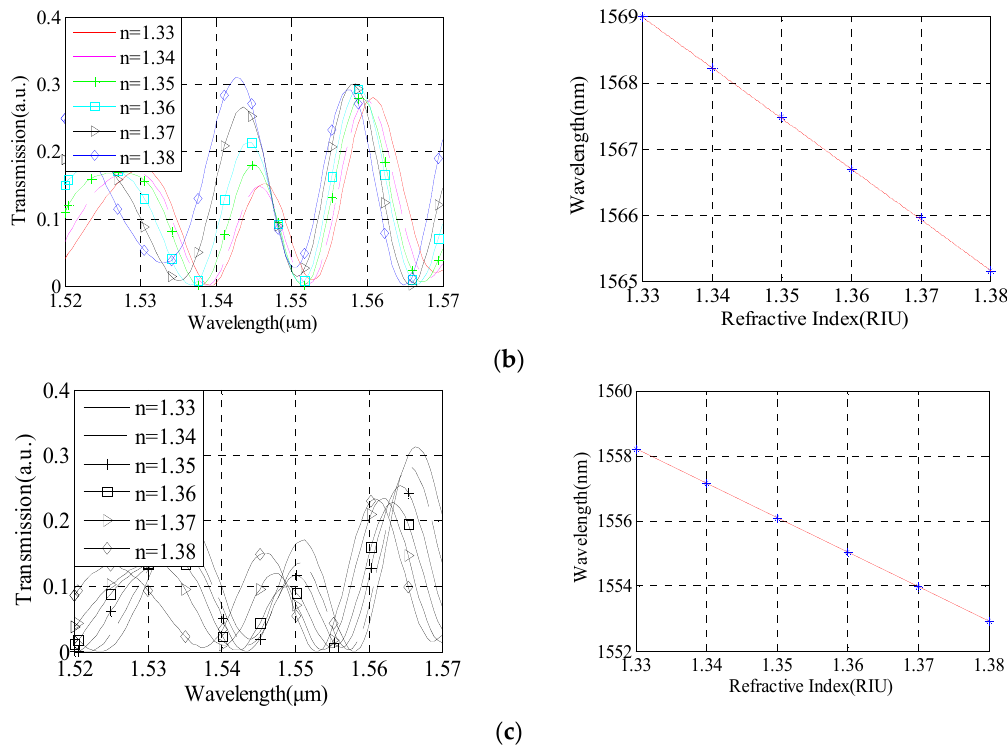
Figure 4. Refractive index measurement sensitivity analysis with different taper waist diameters. ( a )